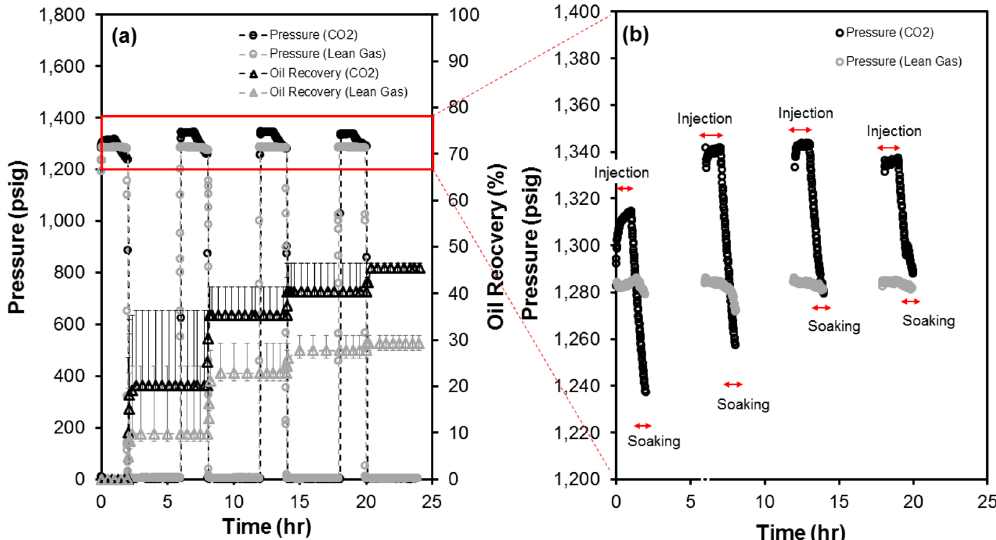
Figure 3. (a,b) Oil recovery and injection/production pressures (4 cycles) as a function of (elapsed) time for the CO 2 and lean gas HNP cycles performed on twin core plug samples (a) . CO 2 data are adopted from Song et al. 28 while lean gas data are generated in this work. Pressure decay profiles for CO 2 and lean gas in an enlarged view (b) .